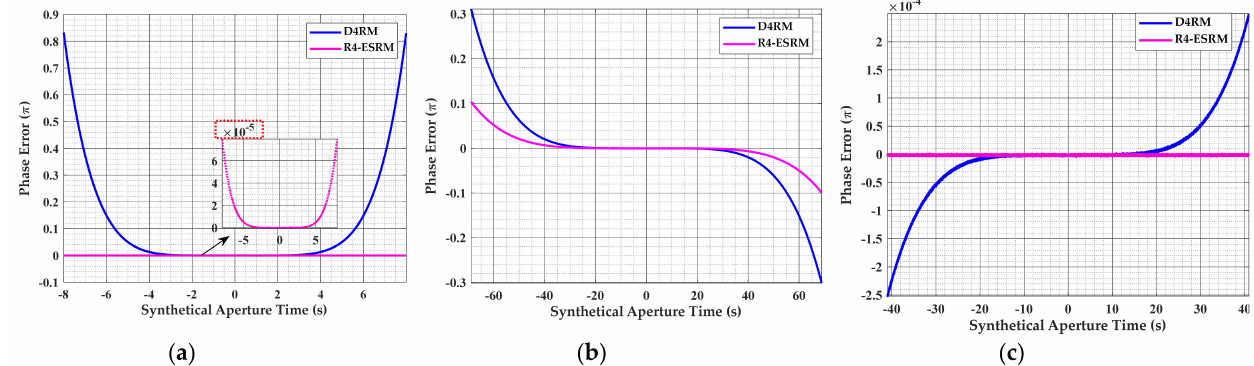
Figure 8. Phase error comparison of different models for HEO SAR at different positions. ( a ) At perigee. ( b ) At squint subduction section. ( c ) At apogee.